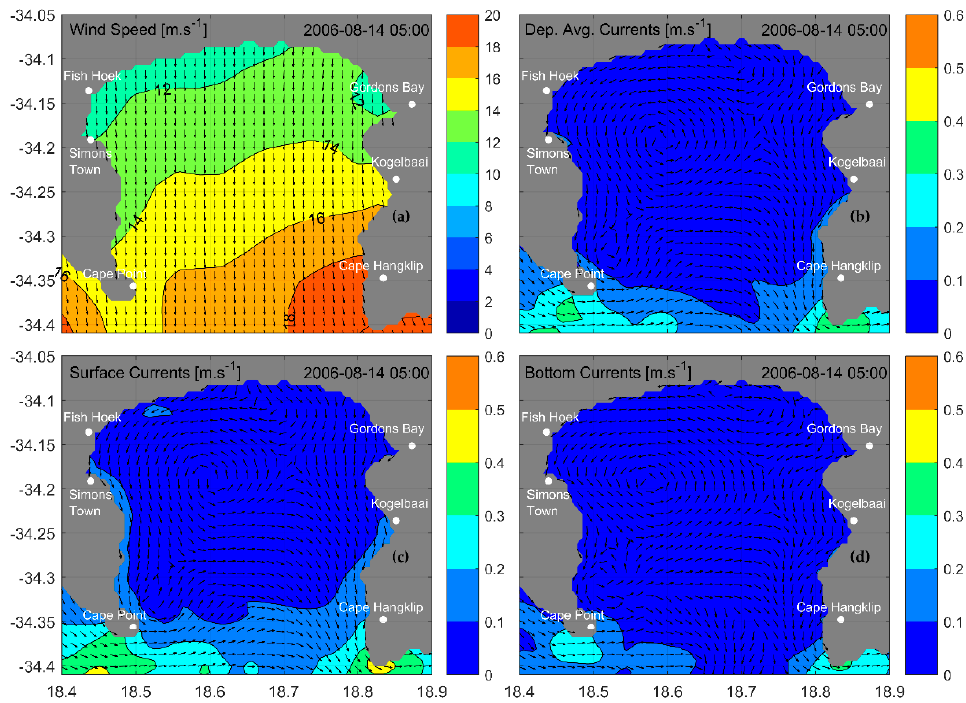
Figure 12. Anticyclonic depth-averaged ( b ) and surface ( c ) flow in False Bay under northerly winds ( a ), with poleward motion at Cape Point and Cape Hangklip preventing the completion of the pattern. Little shear is evident, with bottom flows ( d ) directionally similar to surface flows.